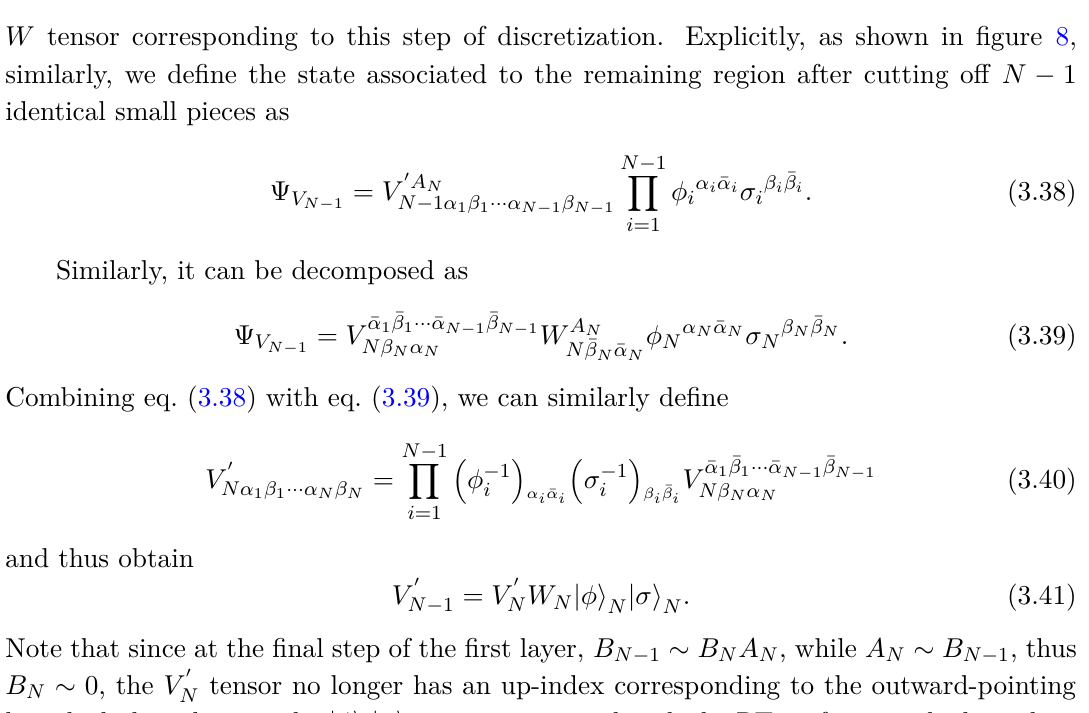
Figure 7 . The third step of